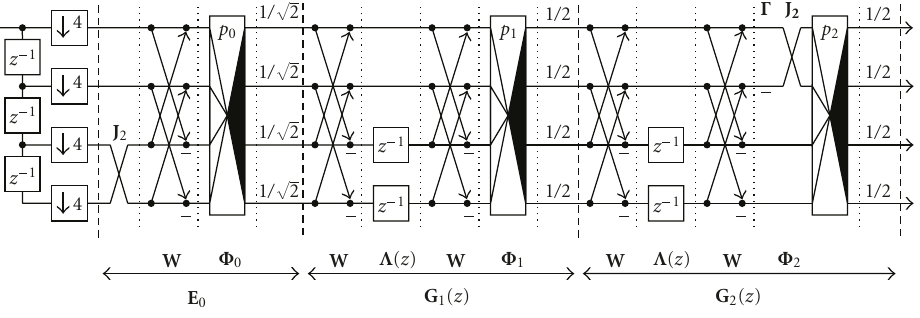
Figure 9: Quaternionic lattice structure for 4-channel PMI LP PUFB ( N =